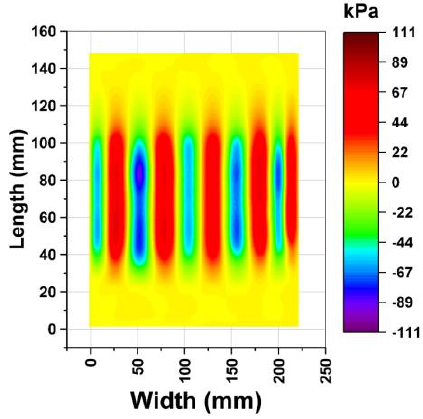
Figure 10. Lateral stress distribution in the tire contact surface.